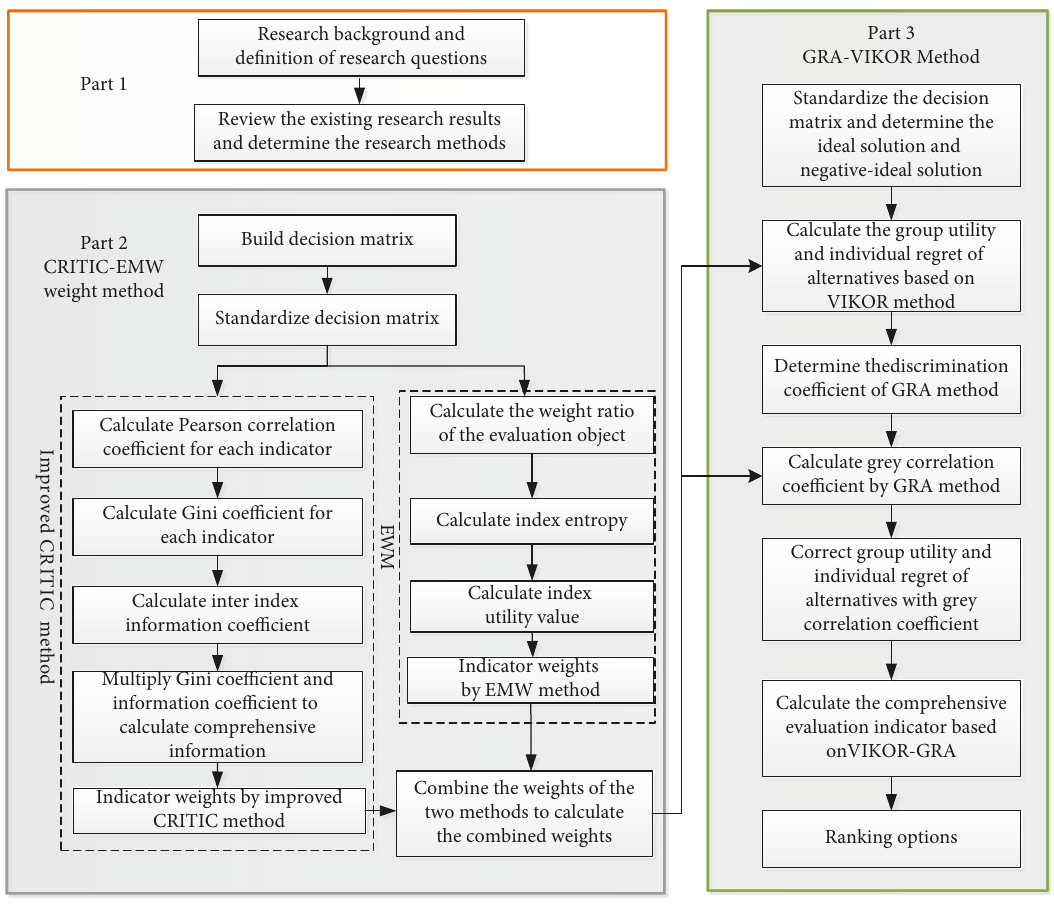
Figure 1: Research